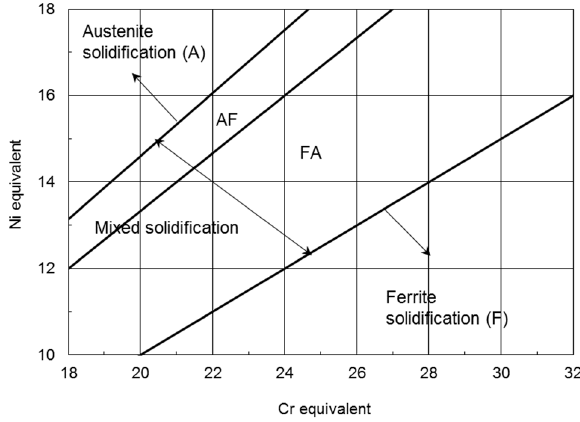
Figure 4. Possible solidification modes and nomenclature according to Equations (1a-d). Table 1. Comparison of nominal chemical composition (wt %) of different materials.